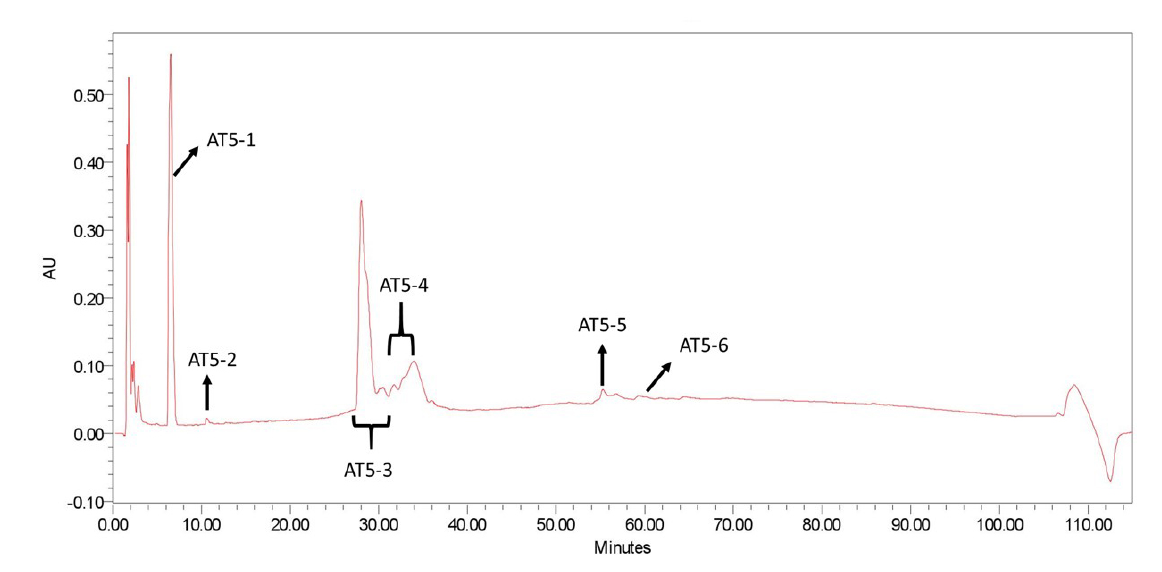
Figure 1. Chromatogram of P. bundokalbo crude spider venom using C18 column: absorbance was measured at